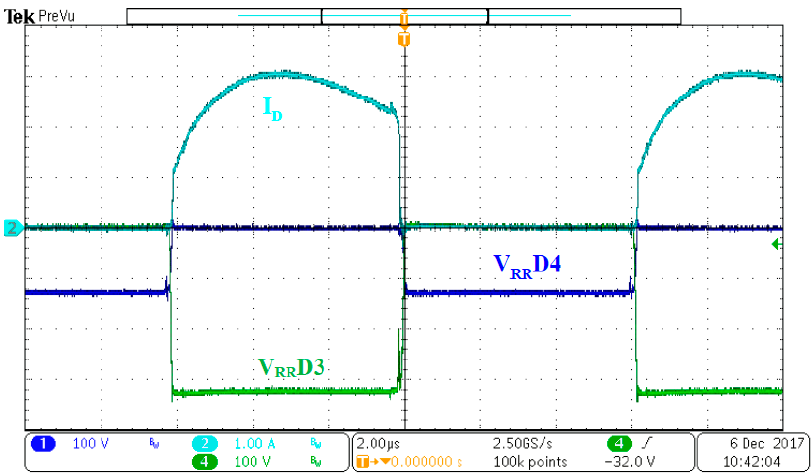
Figure 17. Voltage and current waveforms of the power diodes D 3 , D 4 (100% of output power)— simulation.